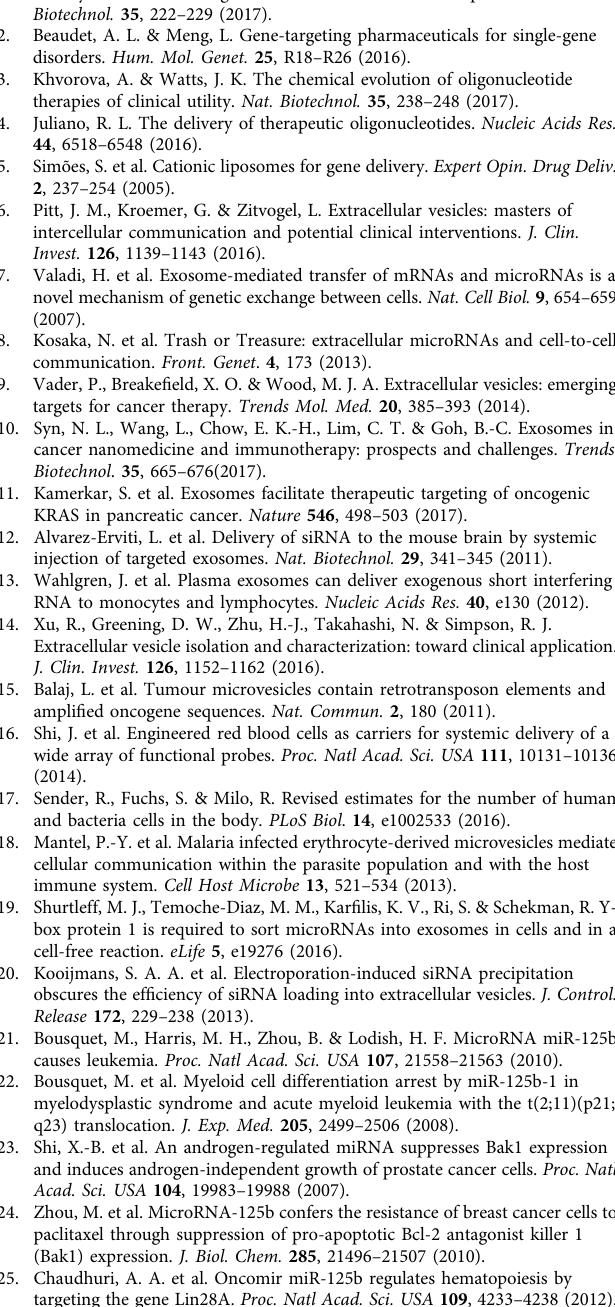
Fig. 3 (https://doi.org/10.6084/m9. fi gshare.593113), Fig. 4 (https://doi.org/10.6084/ m9. fi gshare.5931724), Fig. 5 (https://doi.org/10.6084/m9. fi gshare.5931733), Fig. 6 (https://doi.org/10.6084/m9. fi gshare.5931970), Fig. 7 (https://doi.org/10.6084/m9. fi gshare.5932261) and Fig. 8 (https://doi.org/10.6084/m9. fi gshare.5932654). Next- generation sequencing data of mir-125b mutants are available in Bioproject data- base: ID # PRJNA433779. All other data are available from the authors upon reasonable